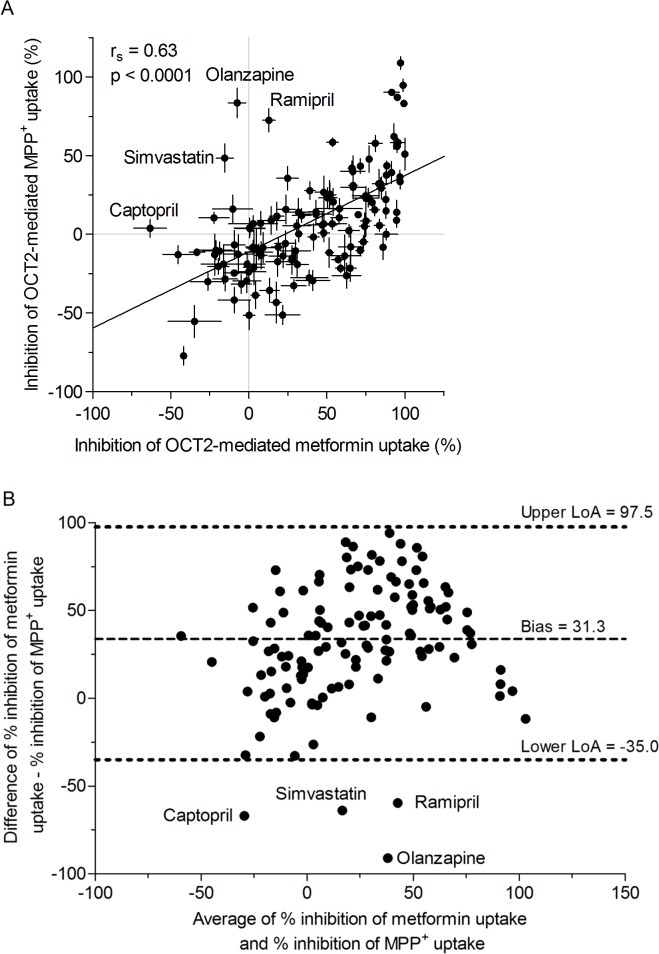
Substrate-dependent differences in the inhibitory profiles and concentration-dependent inhibition of metformin uptake.(A) Correlation analysis between inhibition of OCT2-mediated metformin and inhibition of OCT2-mediated MPP+ uptake in HEK-OCT2 cells. Drugs were tested at 20 μM. Substrate concentrations were 1000 μM for metformin and 50 μM for MPP+ (data are presented as the mean ± standard error, Spearman's rank-order correlation test). (B) Bland-Altman plot (bias and limits of agreement) for the inhibition of OCT2-mediated metformin and MPP+ uptake. Average of % inhibition of metformin uptake and % inhibition of MPP+ is plotted against the difference between % inhibition of metformin uptake and % inhibition of metformin uptake, LoA, limits of agreement. Simvastatin, simvastatin lactone